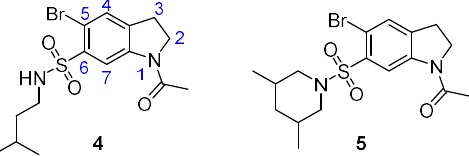
Figure 2. N -Acetyl-6-sulfonamide indoline screening hits from the high-throughput screen (HiTS).